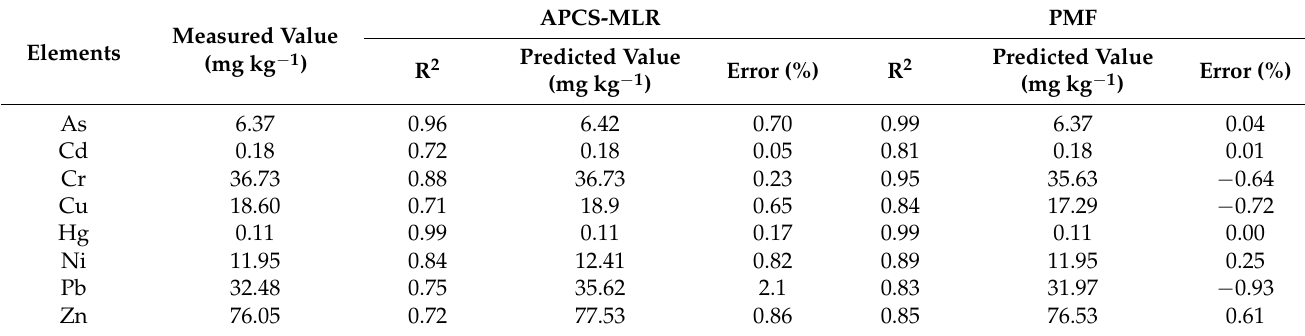
Table 4. Relationship of soil heavy metal concentrations quantified by instrument and predicted by the APCS-MLR and PMF models.